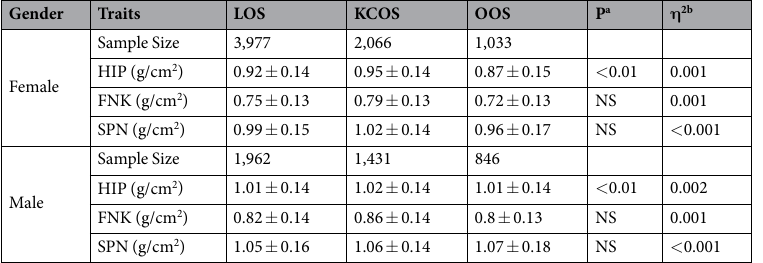
Table 2. BMD of subjects from LOS, KCOS and OOS (mean ± SD). Note: a NS stands for not significant, p > 0.05. b η 2 is eta-squared effect size of ANOVA. In the study, we consider an effect size larger than 0.01 as significant.